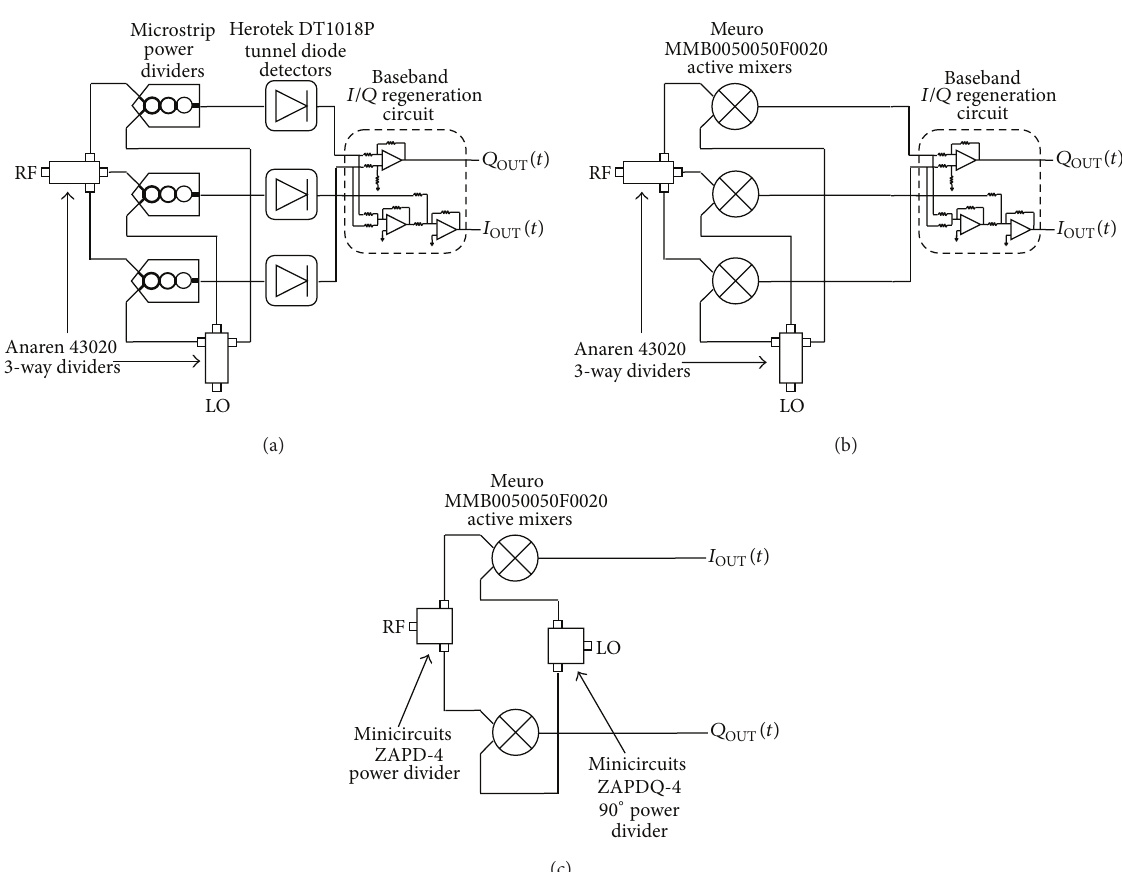
Figure 3: Schematic of (a) FPD and (b) TPD architectures with baseband 𝐼/𝑄 regeneration circuit (c)